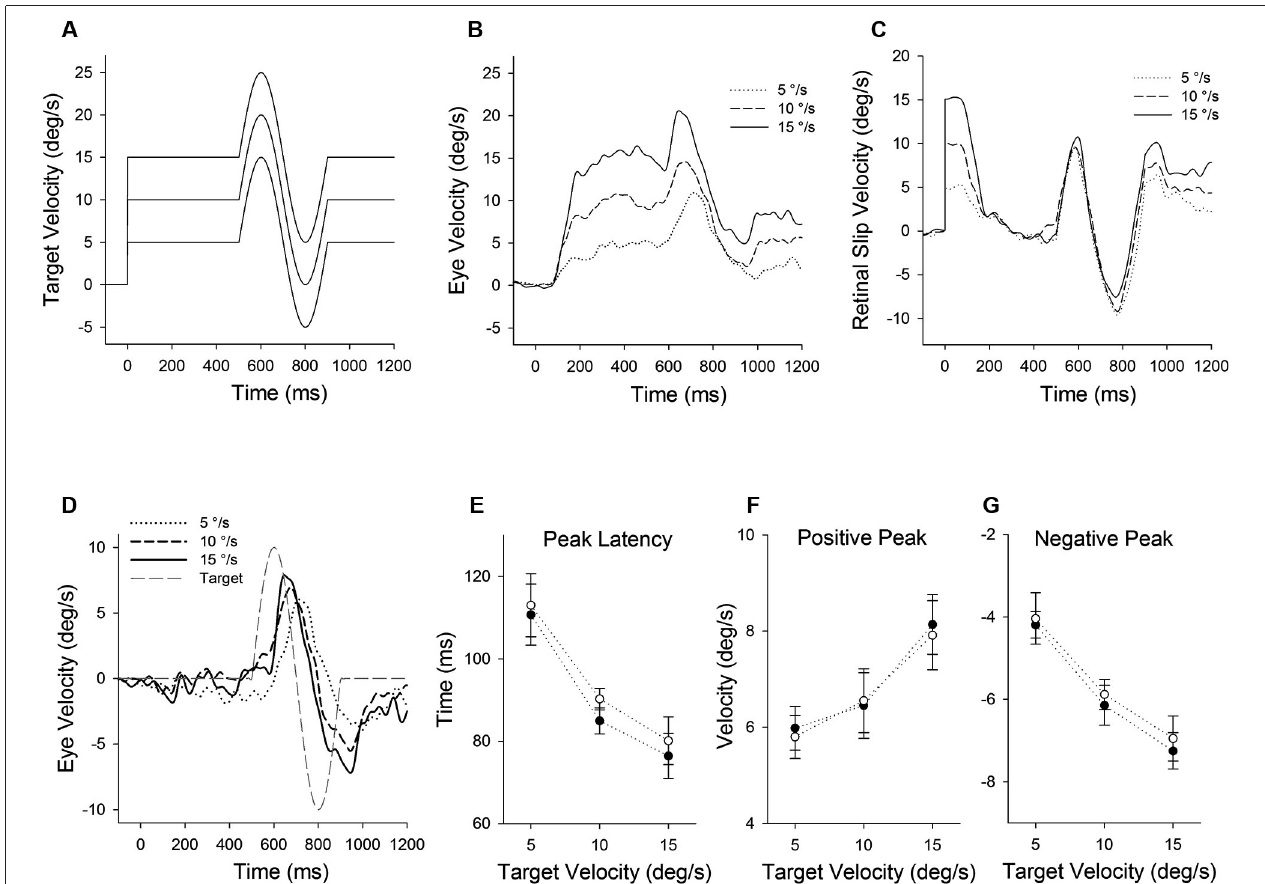
(D) Perturbed eye velocity traces calculated as the difference between eye velocity during step-ramp tracking with and without the perturbation at different ramp velocities (5, 10 and 15 ◦ /s). (E) Mean and standard deviation (SD) values of perturbation latency, (F) positive peak velocity and (G) negative peak velocity are shown as a function of target velocity for two monkeys. Open and filled symbols indicate monkey-P and B, respectively.